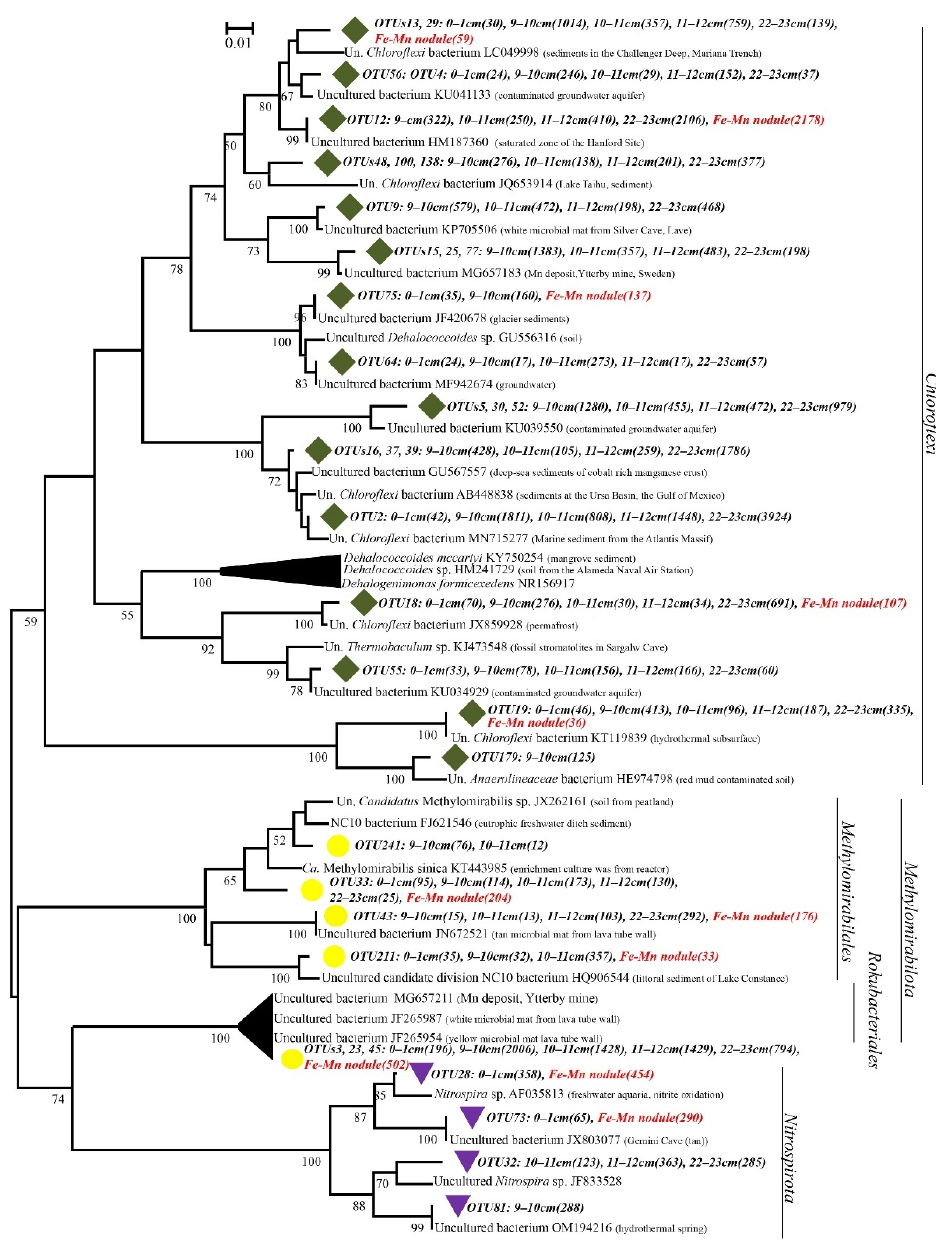
Figure 7. Neighbor-joining (NJ) phylogenetic tree of dominant phyla based on 16S rRNA gene sequences of phyla Methylomirabilota , Nitrospirota , and Chloroflexi . Bootstrap values > 50% (of 100 replicates) are shown in front of respective nodes, and the scale bar represents 5% sequence divergence. OTUs described in this work is represented by circles, lozenges, and upside triangles.